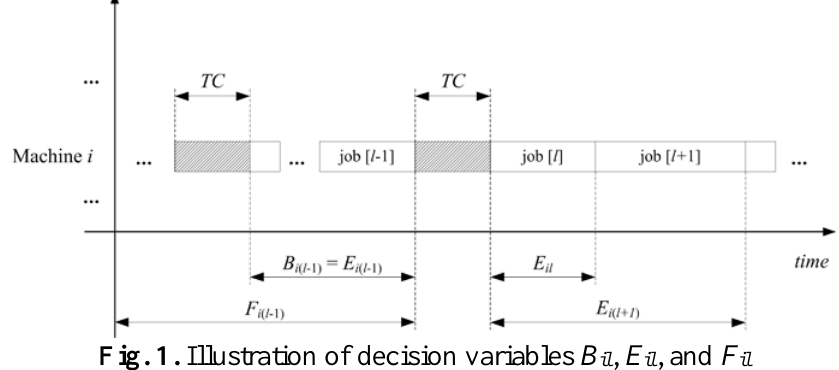
Fig. 1. Illustration of decision variables B il , E il , and F